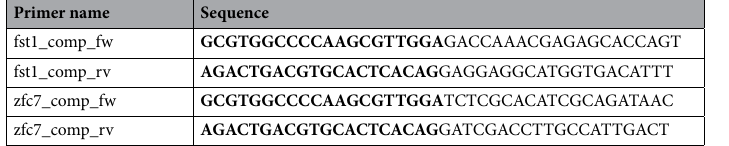
Table 4. Primers used in this study. Bold parts are overlapping regions for Gibson assembly. Underlined parts are protospacers for